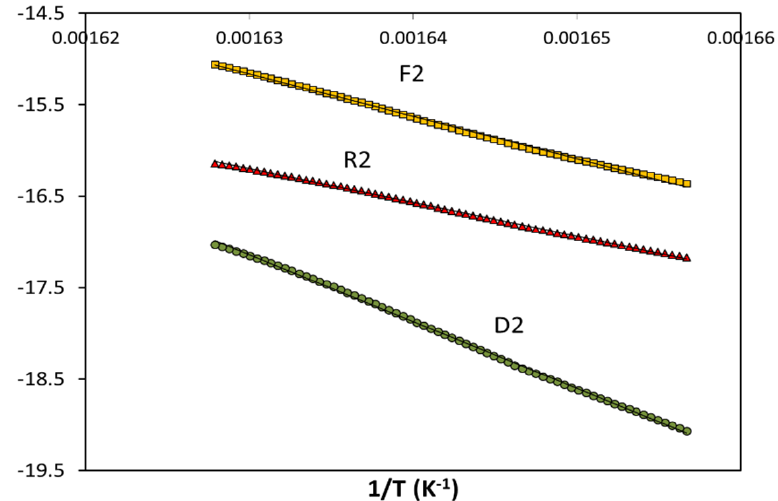
Figure 4. Integral kinetic analysis by means of the general analytical equation (GAE) for the thermal degradation of the bioblend containing 70% PLA using three theoretical conventional mechanisms (F2, R2, and D2) (nominal heating rate = 10 K/min). Table 3. Mean activation energies of the thermal degradation of PLA, obtained using the general analytical equation at various heating rates, for PLA/PA bioblends containing from 50% to 90%